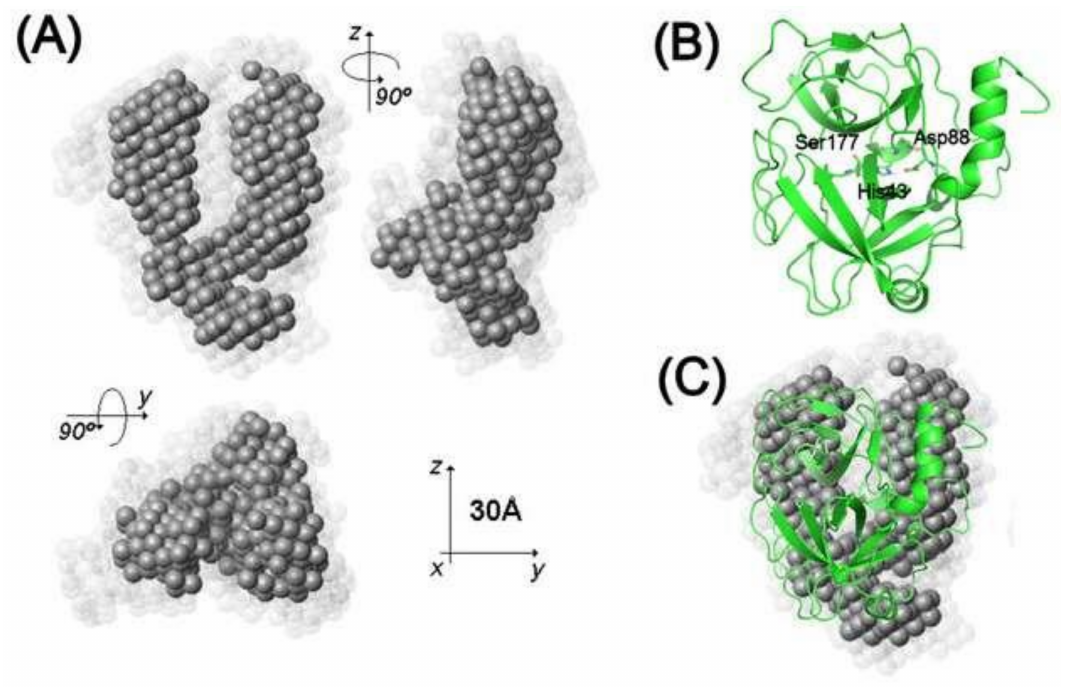
Figure 3. Molecular envelopes, tridimensional structure, and docking of Lmr-47. ( A ) Molecular envelope determined by SAXS at pH 8.0. Ab initio models represent an average of five dummy residue models (DRM) calculations using GASBOR [17]. The light gray spheres in ( A ) represent the space accessible for the DRM as judged by the degree of conservation of a given dummy residue among the five models. ( B ) The three-dimensional structure was obtained by comparative modeling. The structure is presented as a green ribbon, with its active site displayed as sticks (Asp88, His43, and Ser177). ( C ) Superposition of SAXS molecular envelope and the model built by comparative modeling. ( C ) Selected resulting structures of docking calculations with the 4-aminophenylguanidine complex, with the inhibitor colored in blue and the protease in